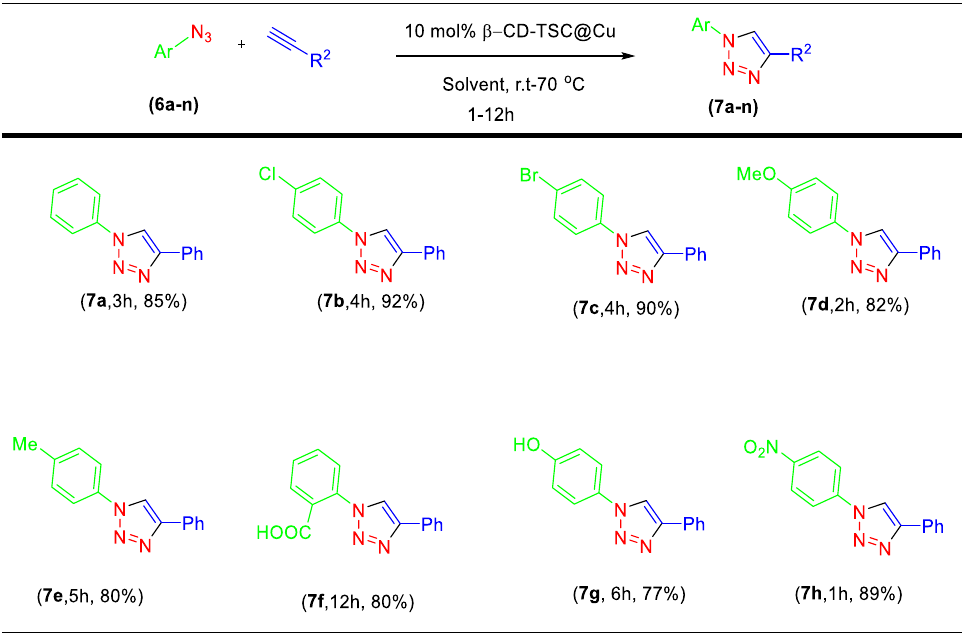
Table 4. Click reaction with aryl